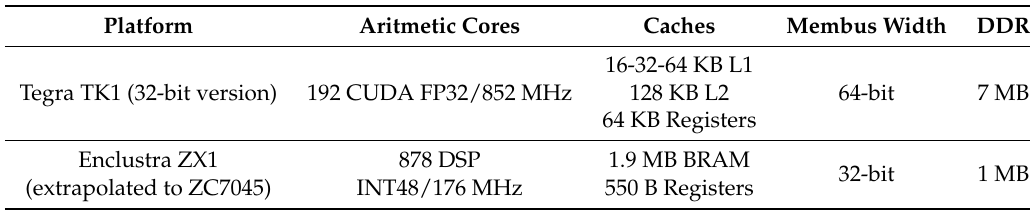
Table 5. Summary of final